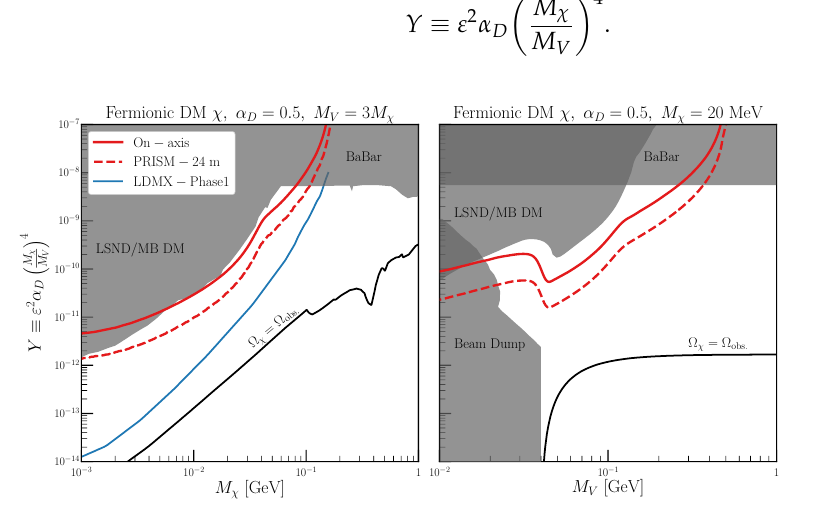
Figure 155. Expected DUNE On-axis (solid red) and PRISM (dashed red) sensitivity using χ e − scattering. We assume α D = 0.5 in both panels, and M V = 3 M χ ( M χ = 20 MeV) in the left ( right ) panel, respectively. Existing constraints are shown in grey, and the relic density target is shown as the black line. We also show for comparison the sensitivity curve expected for LDMX-Phase I (solid blue)